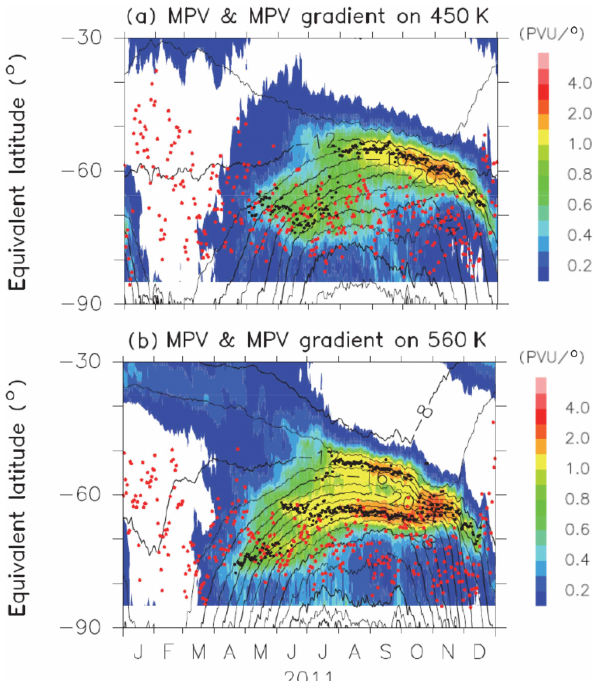
Figure B2. Same as Fig. B1 but for the year in